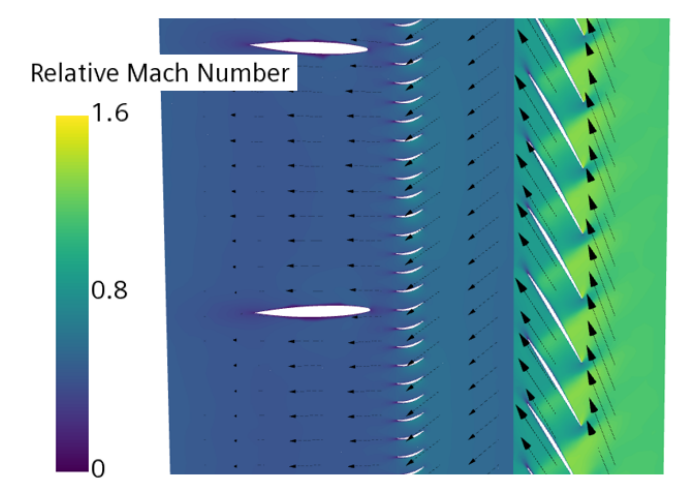
Figure 16. Relative velocity contours and vectors in a rotor and stator